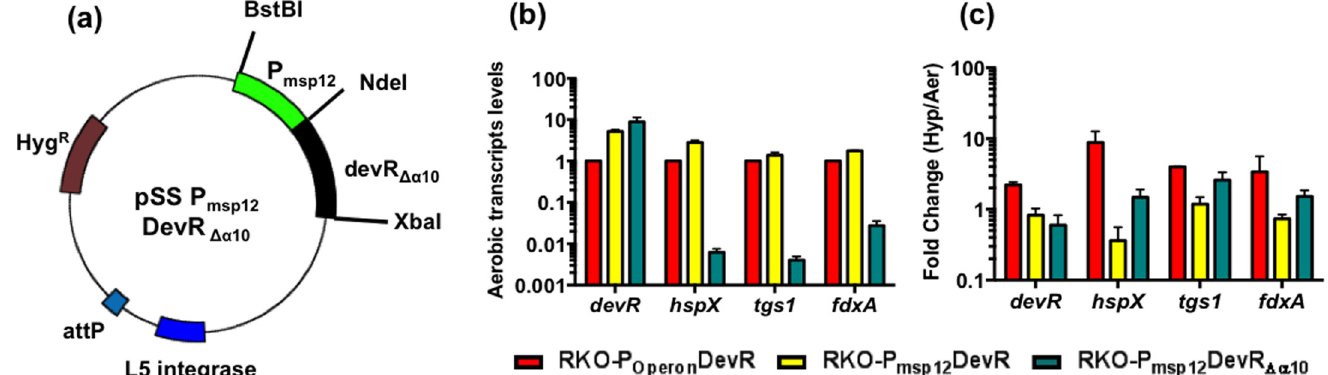
Fig 3. Overexpression of DevR Δα 10 in Mtb RKO. (a) Vector map of integrating plasmid employed to overexpress DevR α 10 protein. (b) RT-qPCR analysis of aerobic DevR regulon genes expression. WT/mutant DevR expression in RKO-P msp12 DevR /RKO-P msp12 DevR α 10 strains is supported by msp12 promoter and WT DevR in RKO-P Operon DevR by its native promoter. (c) RT-qPCR analysis of DevR regulon genes under hypoxia. RT-qPCR data is Mean ± SD of 2 biological